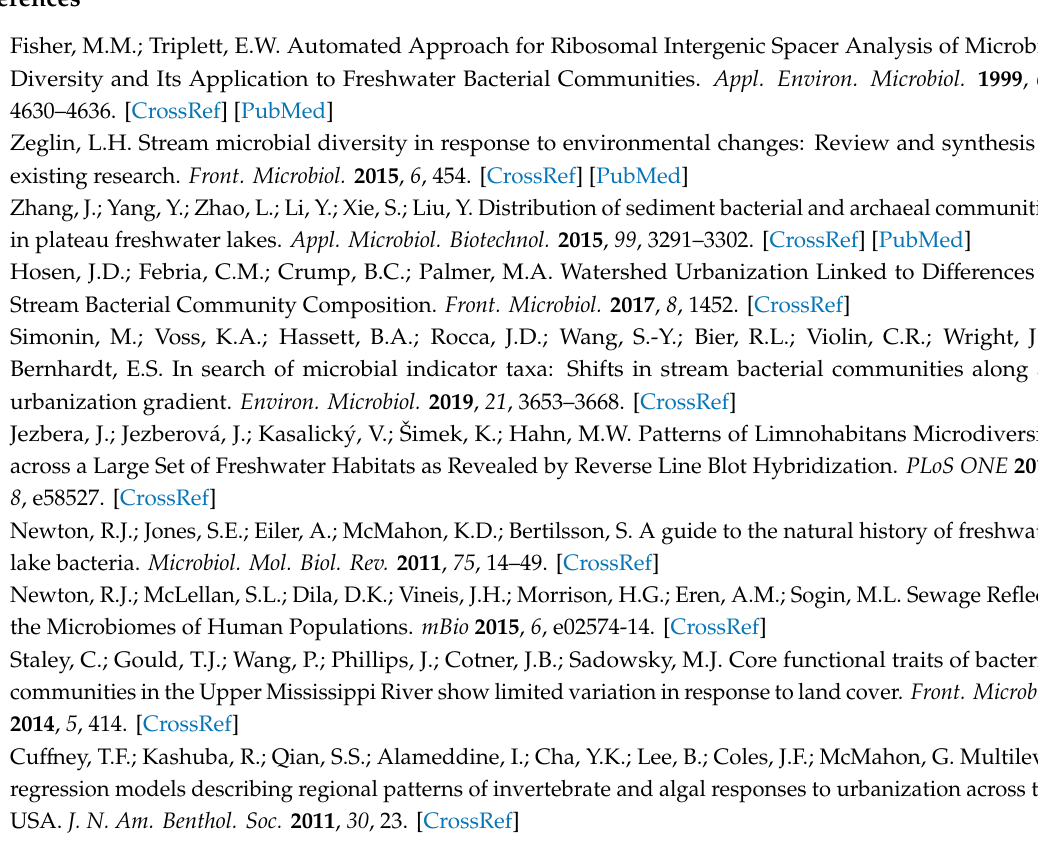
Table S1: Permanova table of Univariate Models, Table S2: The ASVs that were considered novel for Upstream Samples (purple dots, Figure 2A), Table S3: The ASVs that were considered novel for Downstream Samples (purple dots, Figure 2B), Table S4: The ASVs that were considered novel for the WWTP samples (purple dots, Figure 2C), Table S5: The ASVs that were considered novel for Downstream Sediment Samples (purple dots, Figure 2D), Table S6: List of Overlapping ASVs between Upstream and Downstream from Figure S2 with closest Taxonomic Identification, Table S7: List of Overlapping ASVs between WWTP and Downstream from Figure S2 with closest taxonomic identification. NGS datasets created in this study are deposited in the SRA, accession number